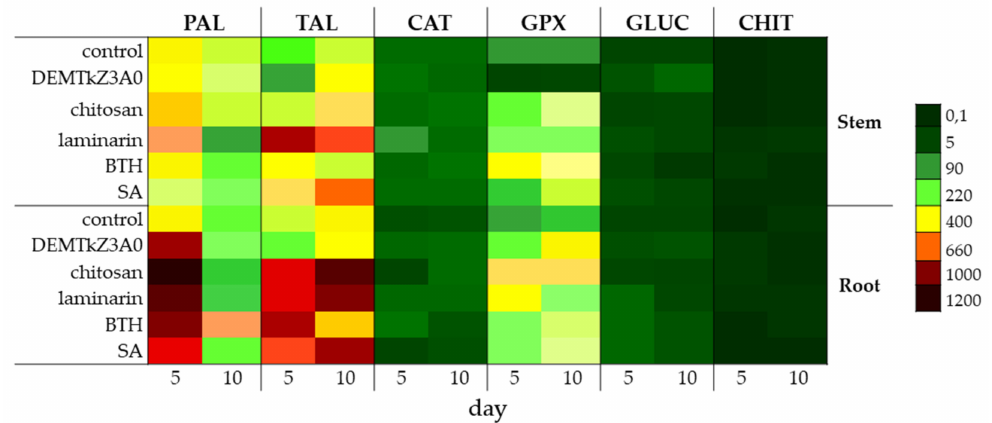
Figure 18. The heatmap allowed to compare PAL—phenylalanine lyase, TAL—tyrosine lyase, CAT—catalase, GPX—guaiacol peroxidase, GLUC—glucanase, CHIT—chitinase activity in the stems and roots of wheat inoculated with Trichoderma DEMTkZ3A0 strain or treated with commercial elicitors after 5 and 10 days of incubation. The color scheme of the heat map fields represents the concentration in nMol / mg